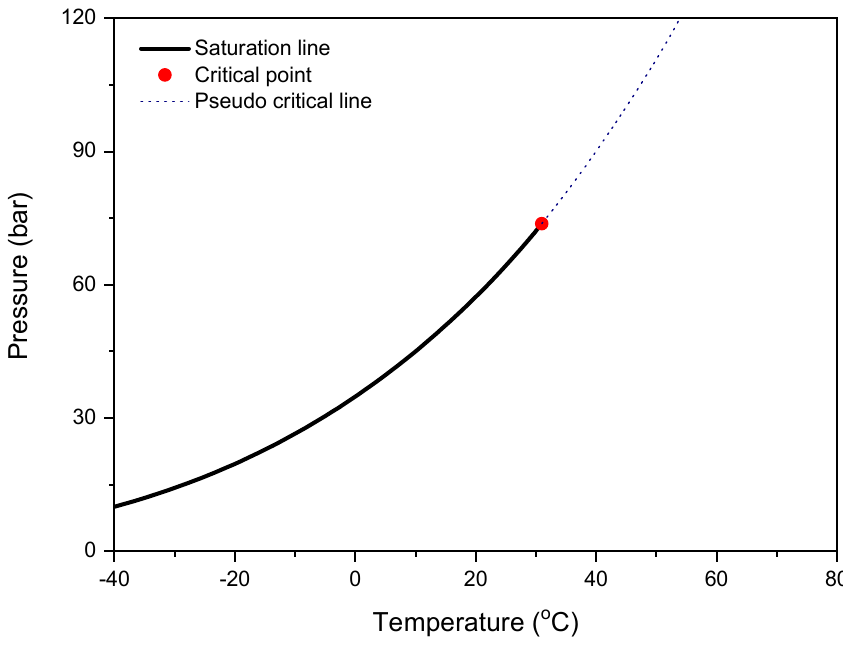
Figure 1. Phase envelope of pure CO 2 .